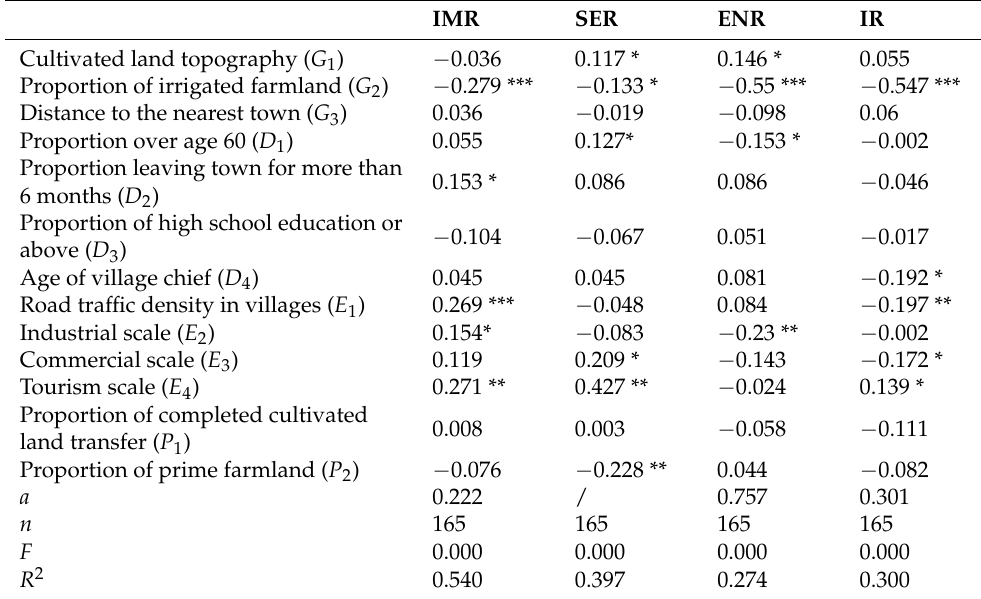
Table 4. Multiple linear regression model results for four given non-grain production categories.